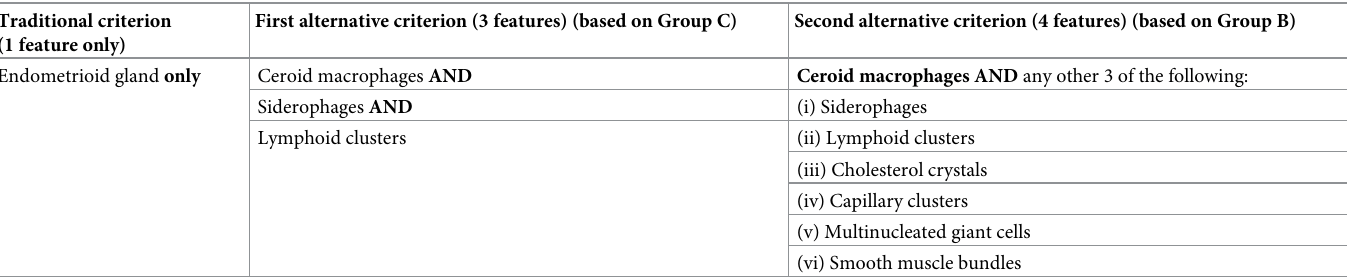
Table 4. The traditional criterion and two new suggested alternative criteria for the diagnosis of thoracic endometriosis. These new alternative criteria are based on the features of Groups C and B. Traditional criterion (1 feature